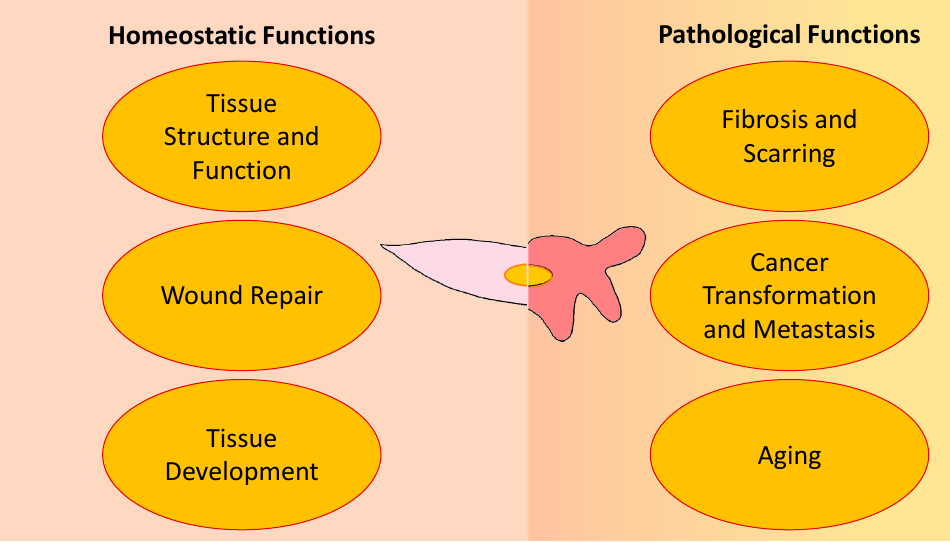
Figure 1. Homeostatic and pathological functions of fibroblasts ( left ) and myofibroblasts ( right ). Fibroblasts normally perform a number of key supportive roles in healthy tissues, and ideally contribute to the non-pathological healing of wounds. In response to physical and chemical signals, fibroblasts activate and undergo phenotypic conversion to myofibroblasts, altering their function. Persistence of myofibroblasts may lead to a failure to resolve repair processes such as wound healing, which in turn can lead to fibrosis and replacement of functional tissue with non-functional scar, can promote cellular transformation and metastasis in cancer, and can contribute to tissue aging. The negative impacts of fibroblast activation on tissue function can range from being relatively minor or cosmetic, to life-threatening.